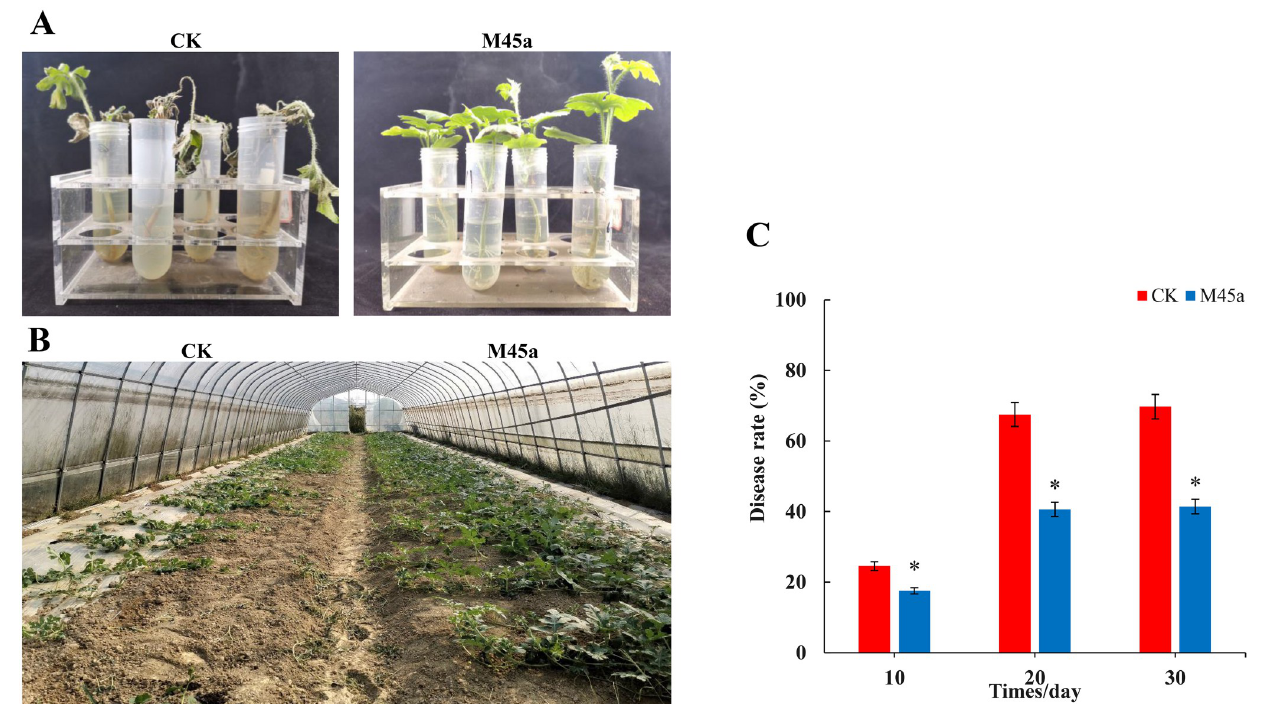
Fig 1. Biocontrol effect of the T . asperellum M45a strain on watermelon Fusarium wilt. The inoculation of T . asperellum M45a (M45a). The noninoculated control (CK). A: Hydroponic test of the effect of M45a treatment on watermelon wilt control; B: The effect of different treatments on the incidence of FW disease on watermelon in the field; C: The effect of different treatments on watermelon growth and FW on the 20th day in the field ( � P < 0.05; �� P < 0.01).